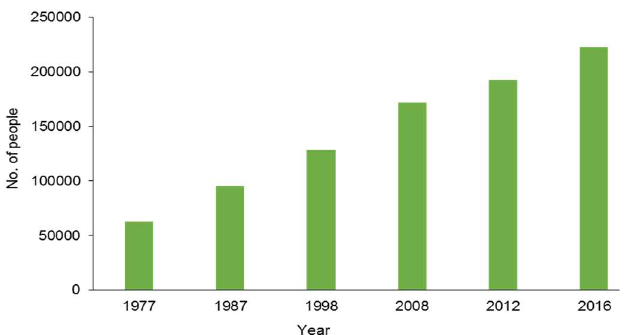
Figure 11. Population of the Rumphi district 1977–2008 and projected population 2012–2016. Data